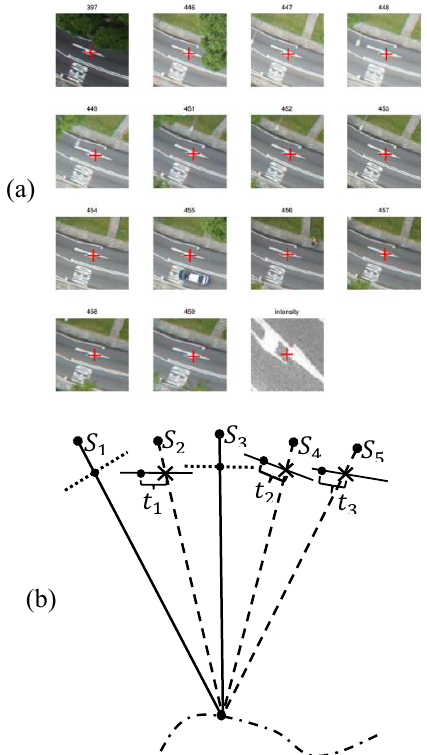
Figure 4. (a) shows the result of template matching as tie points between the intensity map (the last one ) and UAV images with the cross marker. (b) illustrates the RANSAC procedure based on the result of template matching. G represents a ground point with chosen image 𝑆 𝑡 , i = 1,2,3 is the difference of a spot representing 𝑖 matched point and a cross representing the computed in 𝑆 , 𝑆 𝑆 5 4